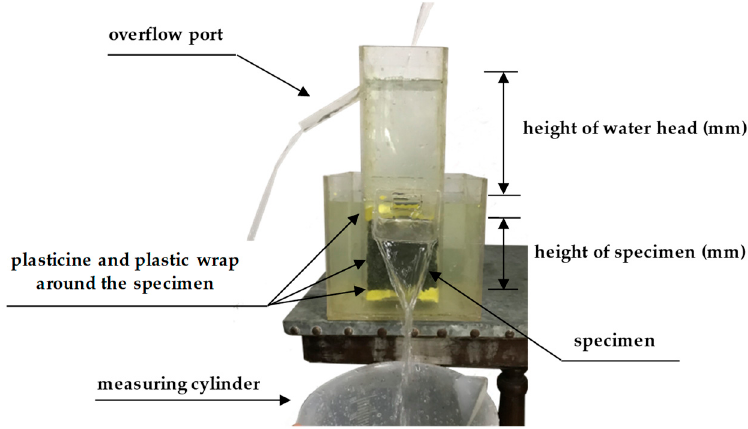
Figure 2. Permeability test apparatus.